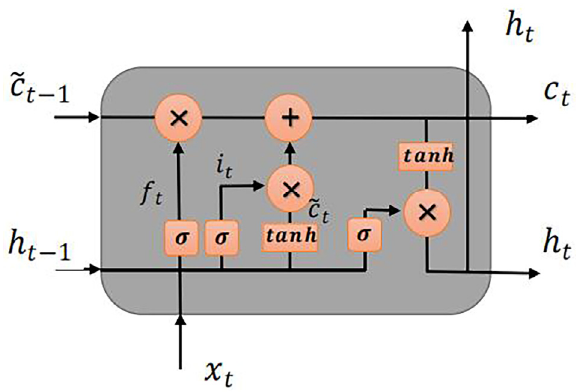
Figure 2. The structure of Long ‐ Short Term Memory (LSTM) cell.